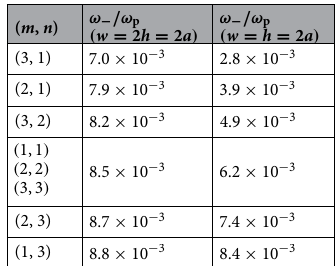
Table 1. Normalized cutoff frequencies for electrostatic modes ( m , n ) ( n = 1, 2, 3 and m = 1, 2, 3 ) of a waveguide filled with a medium of nanowire-based HMMs with r = 5 nm, d = 1 µ m, using Eqs. (23) and (24).